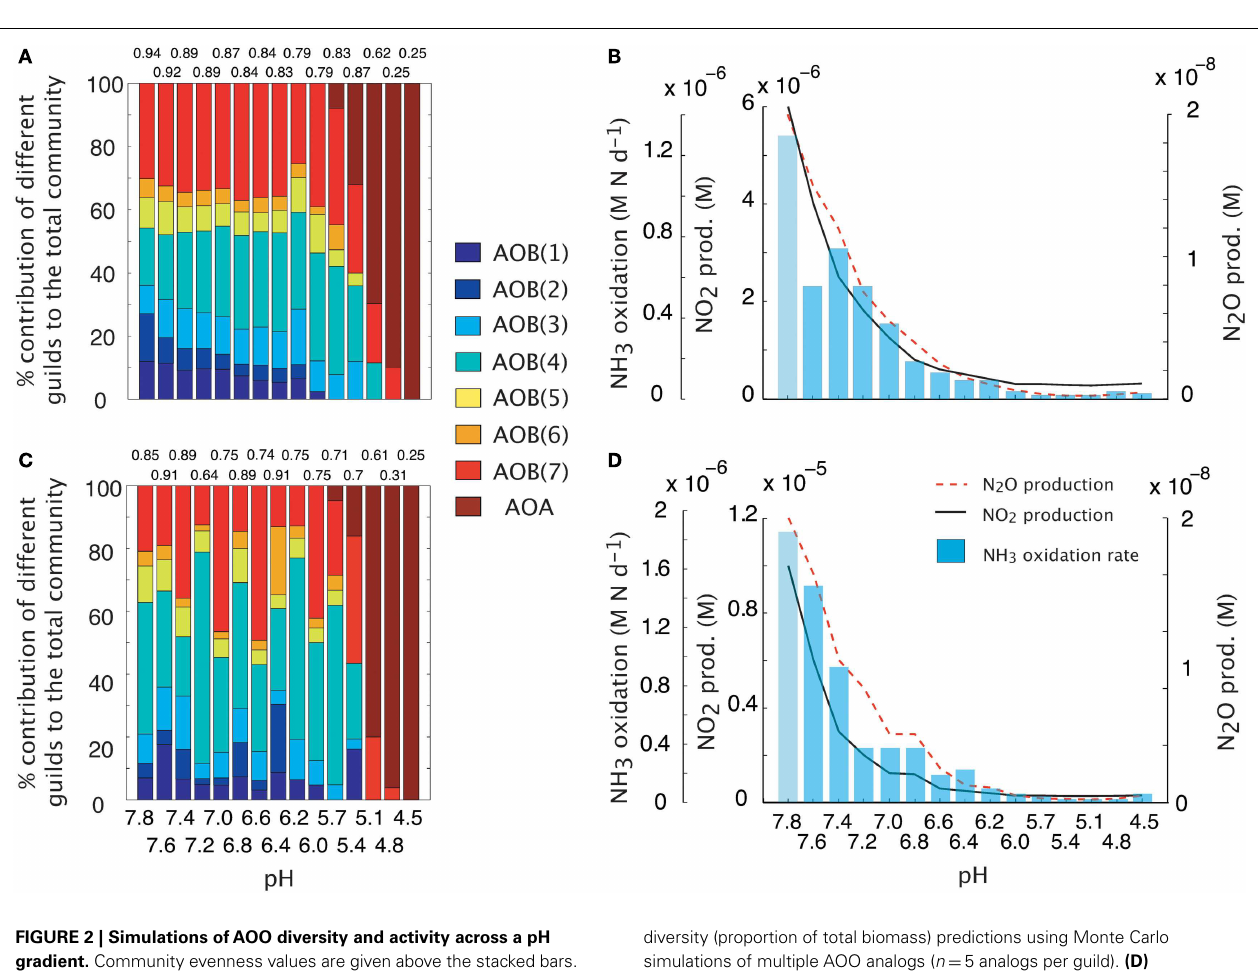
diversity (proportion of total biomass) predictions using Monte Carlo simulations of multiple AOO analogs ( n = 5 analogs per guild). (D) Simulated nitrifier activity (NH 3 oxidation, NO 2 production, N 2 O production) using Monte Carlo simulations of multiple AOB analogs ( n = 5 analogs per